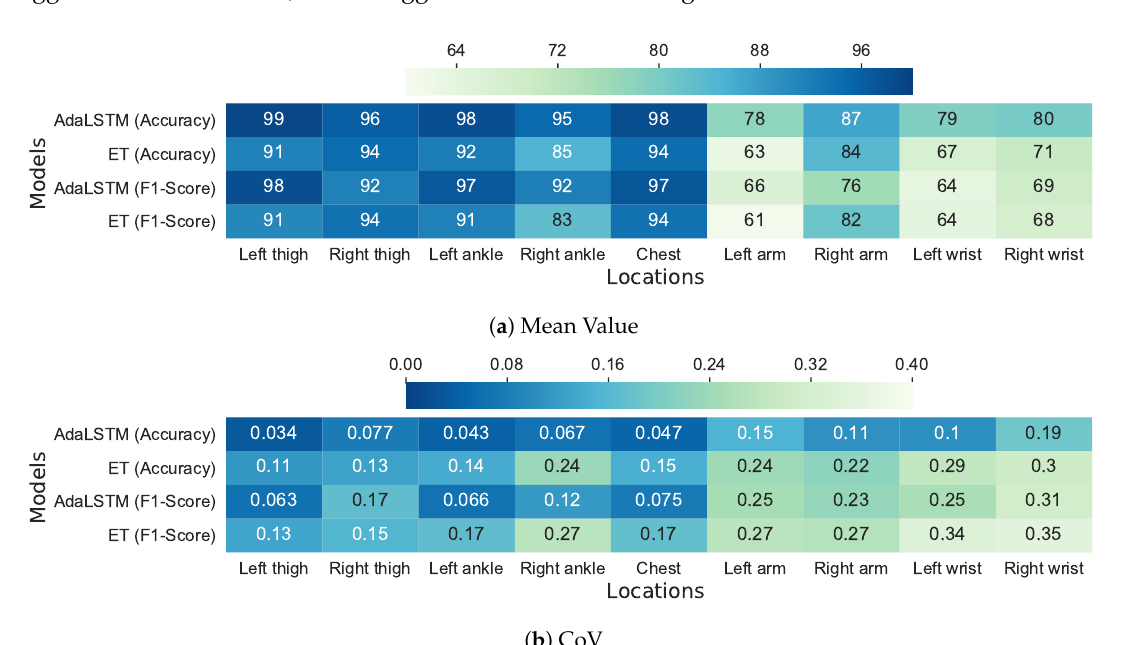
Figure 8. Comparison between the mean and CoV of F 1 score (%) of the ensemble tree and AdaLSTM classification models for nine body locations on the Class-Act dataset using LOSO